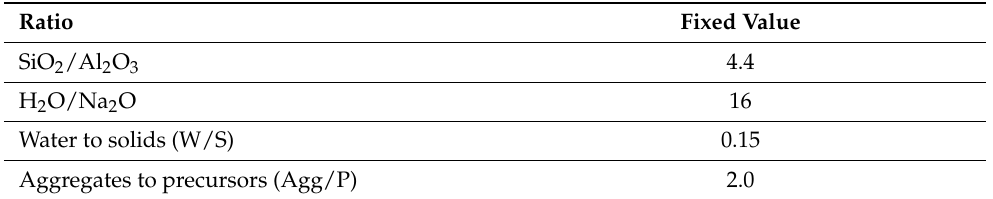
Table 4. Fixed geopolymerization ratios.